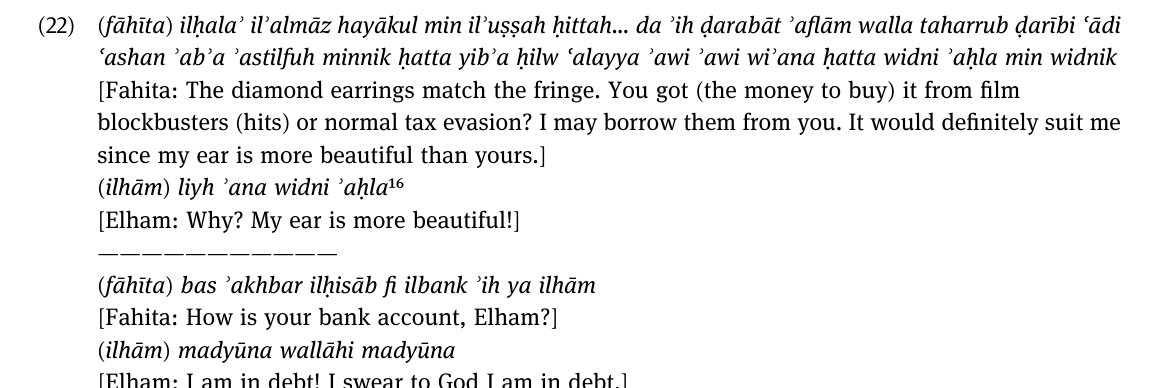
[ Fahita: The diamond earrings match the fringe. You got ( the money to buy ) it from fi lm blockbusters ( hits ) or normal tax evasion? I may borrow them from you. It would de fi nitely suit me since my ear is more beautiful than yours. ]